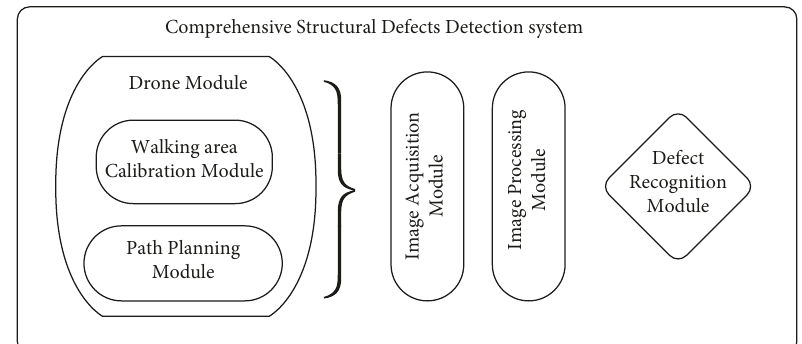
Figure 3: Defect detection